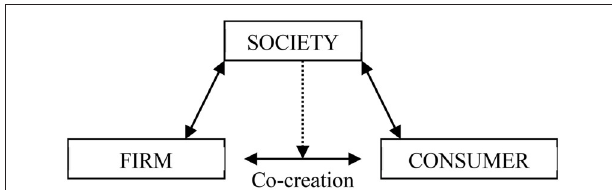
FIGURE 1 | The S-D Logic: Social values based view of Marketing and Consumers’ co-creation